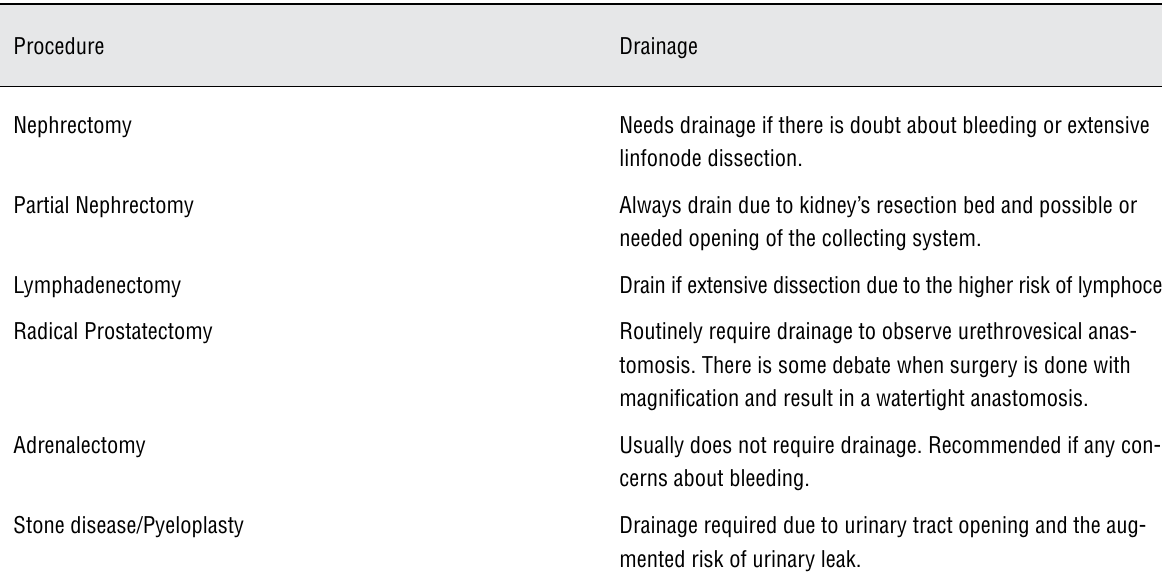
Table 4 - urologic laparoscopic